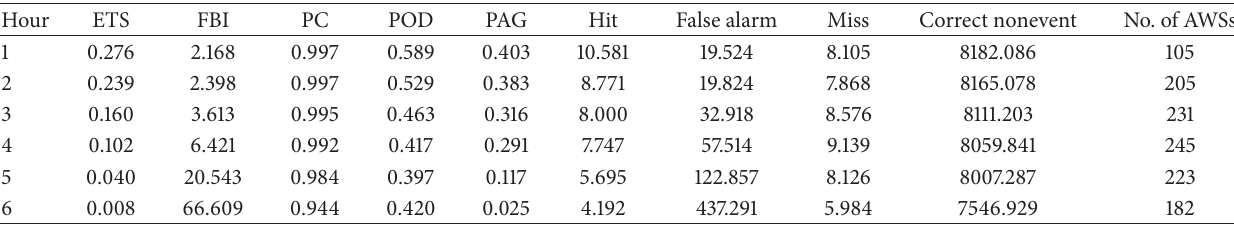
Table 10: Results of GA with SVM from 1 to 6 hours (CE).